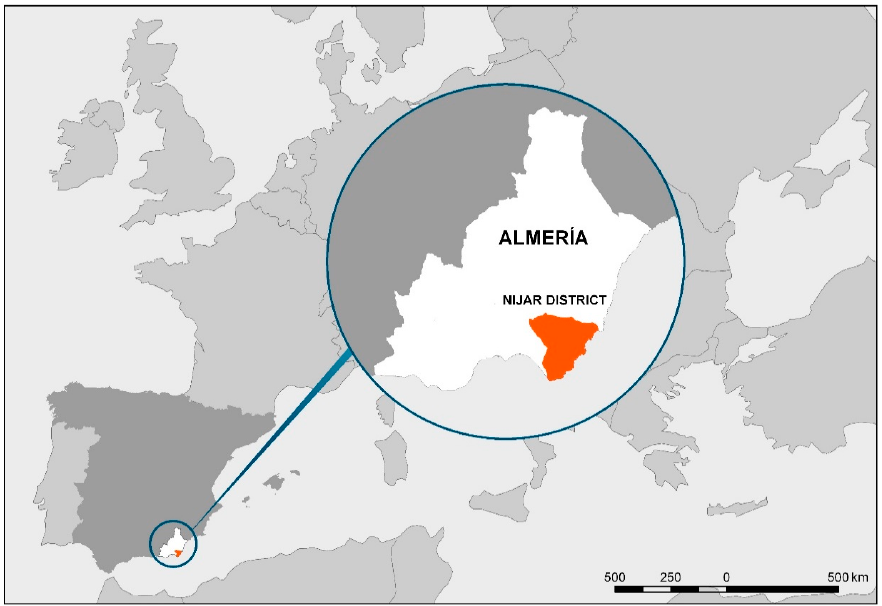
Figure 1. Location of Níjar District (Almería) in the Southeast of Spain.